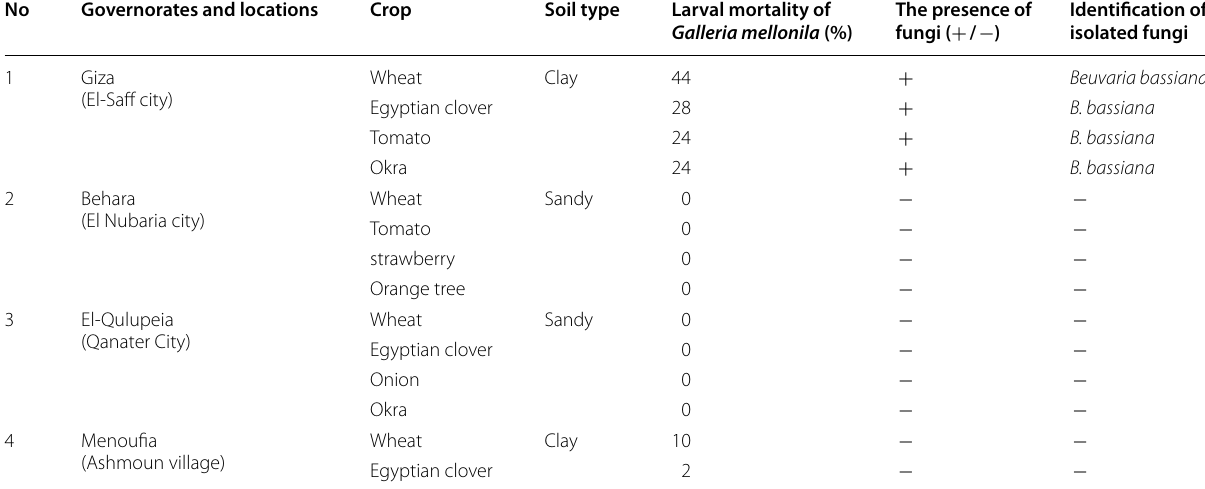
Table 1 Isolation and identification of entomopathoginic fungi from soil samples of different Egyptian governorates No Governorates and locations